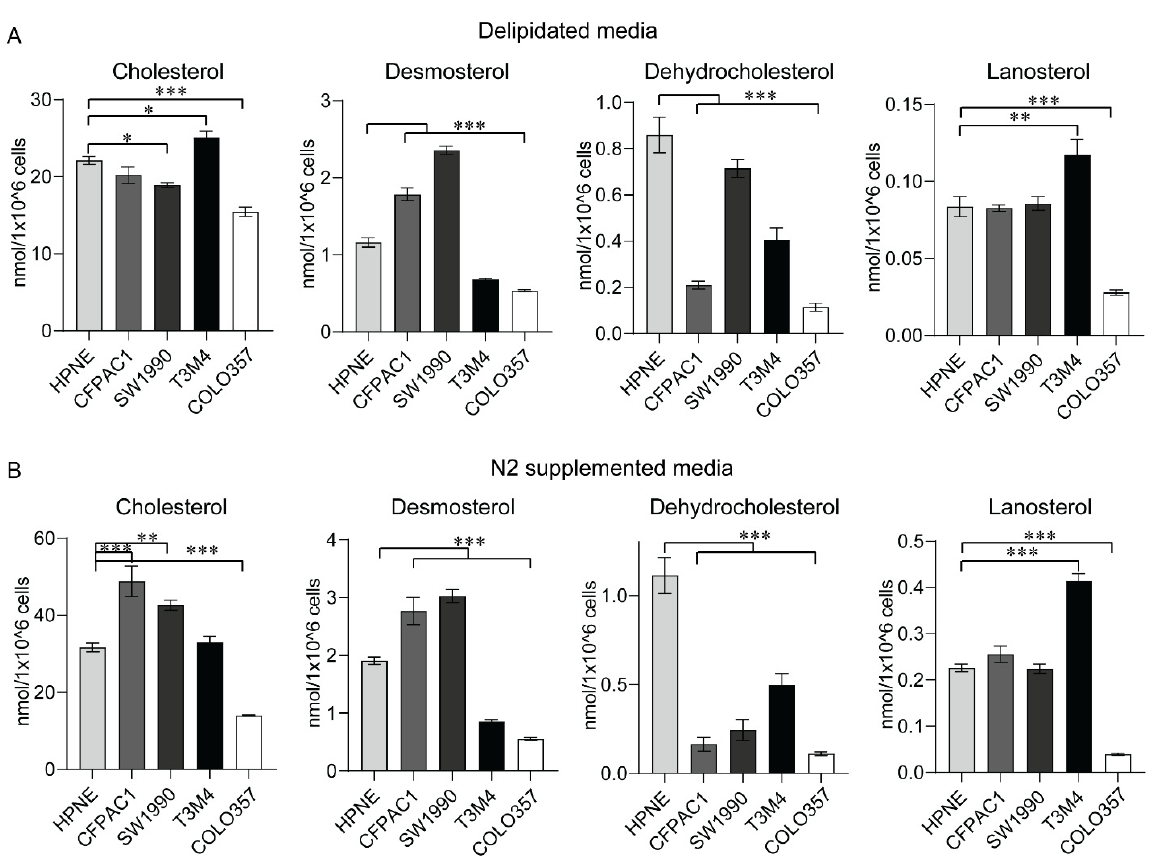
Figure 5. Sterol levels in pancreatic cancer cell lines alter with lipid deprivation. Mean and standard deviation bar plots depicting sterol quantification from immortalized pancreatic epithelial cell line (HPNE) and pancreatic ductal carcinoma cell lines (CFAPC1, SW1990, T3M4, and COLO357) grown in a delipidated medium are shown in panel ( A ), and N2-supplemented medium is shown in panel ( B ). *, **, and *** indicate p < 0.01, <0.05, and <0.001, respectively, which were obtained through one-way ANOVA analysis.